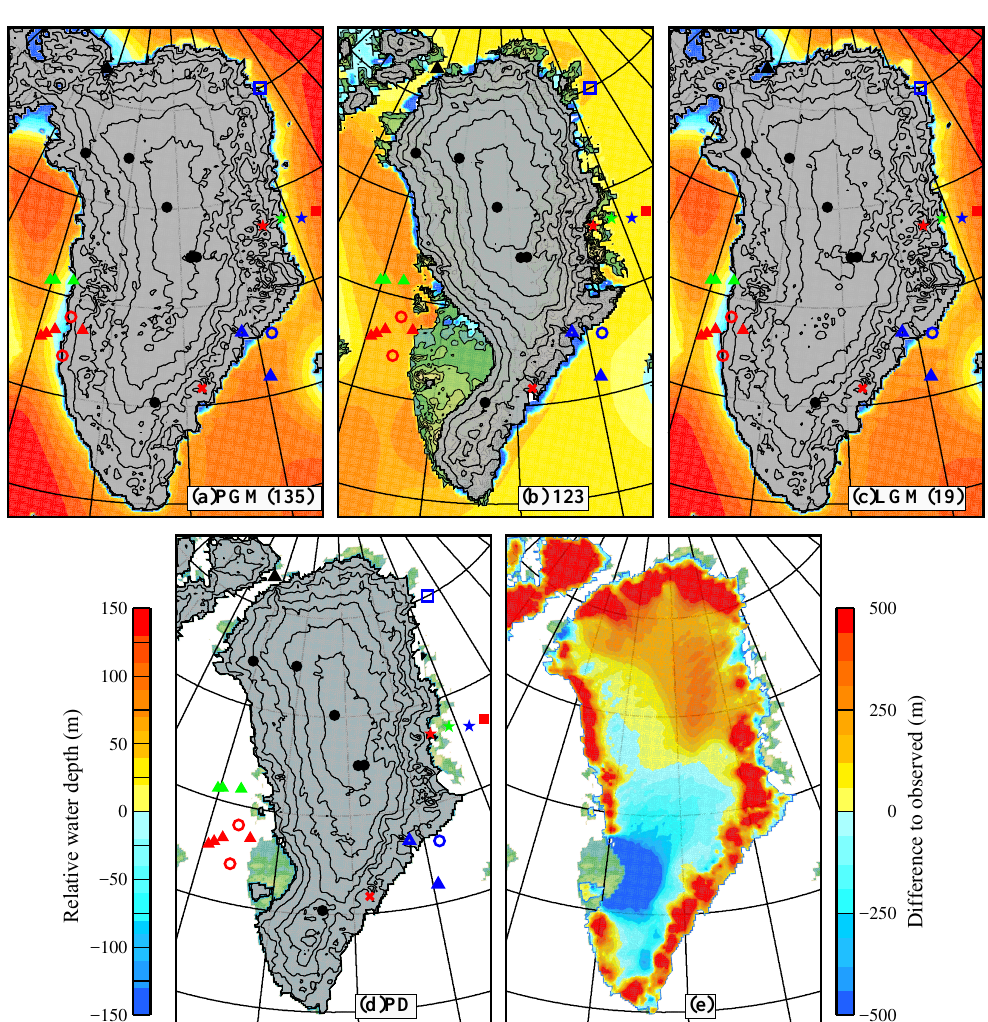
Figure 5. Simulated extent of the grounded ice sheet and relative water depth using the parameters highlighted in Table 3 (Av A s + AvSSM1) at four time periods: (a) Penultimate Glacial Maximum (PGM), 135ka BP; (b) Last Interglacial (LIG) minimum, 123ka BP; (c) Last Glacial Maximum (LGM), 19ka BP; and (d) the present day (PD). Panel (e) is the difference in the present-day surface elevation (relative to the observed surface elevation; Bamber et al., 2013), where positive value indicates an overprediction. The black circles mark the location of the GrIS ice core sites. Observed data constraining the timing of retreat is summarized in Table 1. Note that the colour bar extended beyond ( ± ) 150. Small floating ice shelves formed at the edge of the grounded ice sheet, but these are not